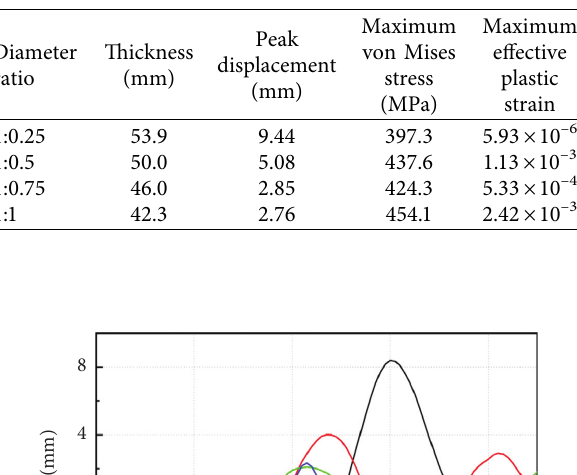
Table 8: Displacement, von Mises stress, and effective plastic strain of the EBD with different diameter